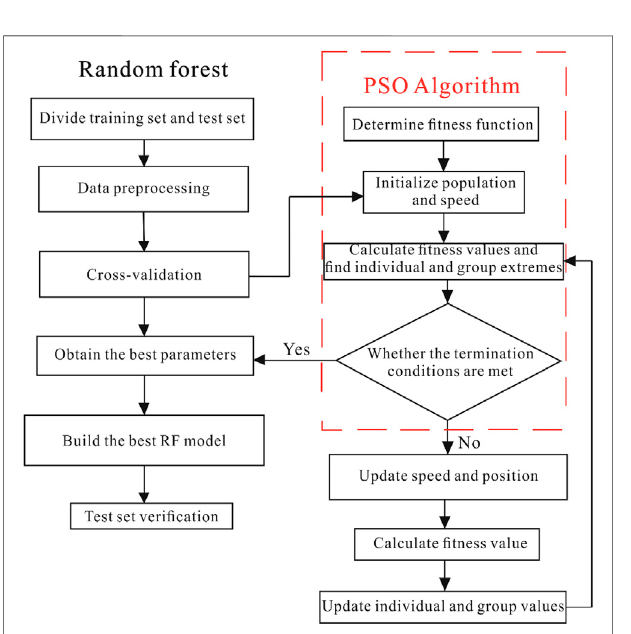
FIGURE 7 | Random forest model optimized by the particle swarm optimization (PSO).